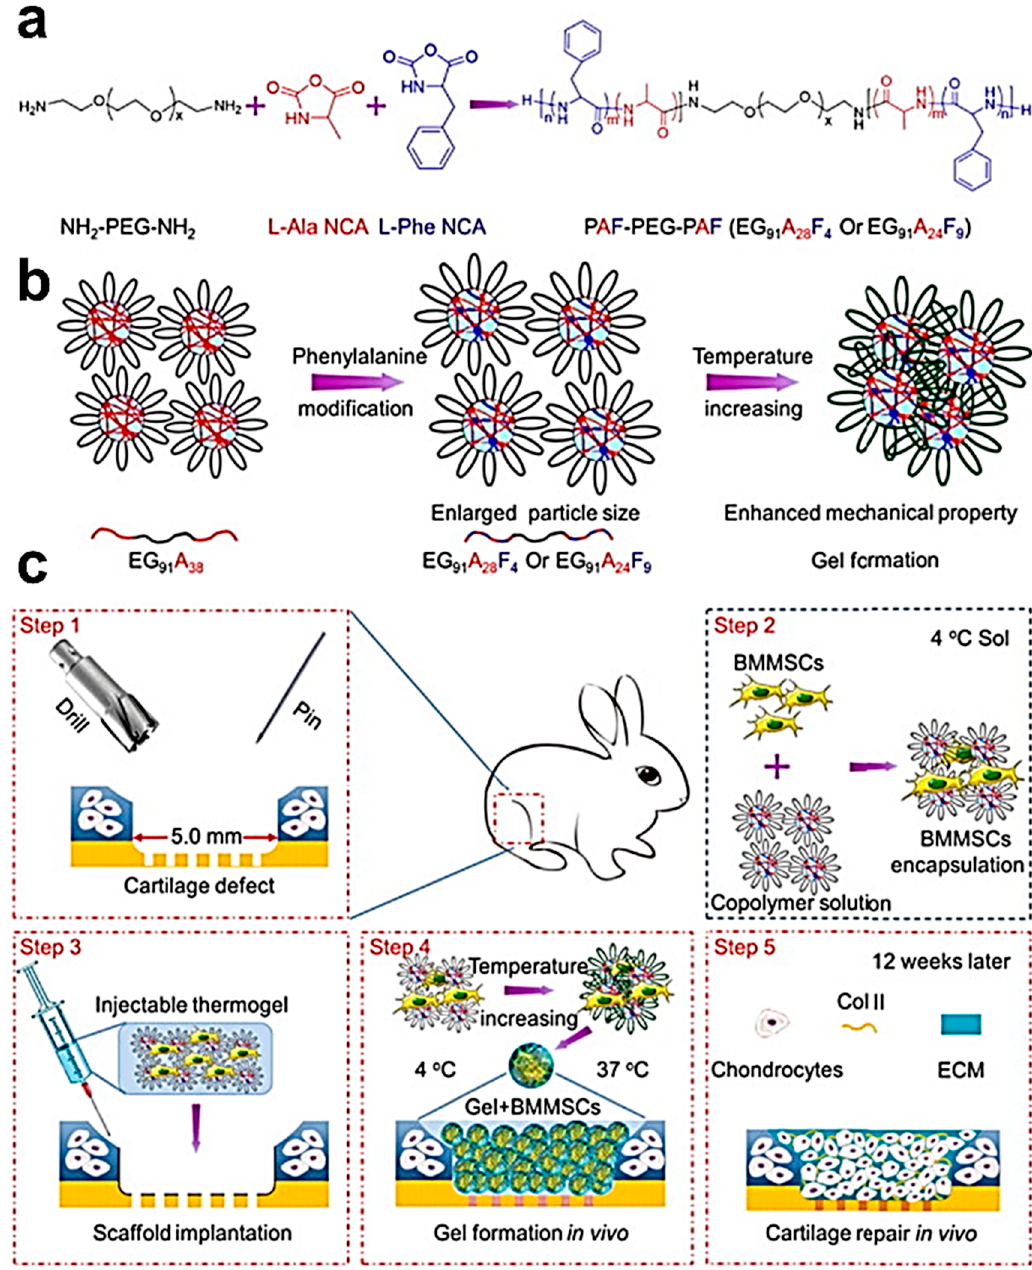
Figure 5. ( a ) Synthetic routes of PAF-PEG-PAF copolymers, ( b ) schematic illustrations of sol-to-gel transition of PAF-PEG-PAF aqueous solutions, and ( c ) procedures regulating BMMSCs chondrogenesis in a rabbit osteochondral cartilage defect model. Reproduced with permission from [156]. Copyright Elsevier, 2018.